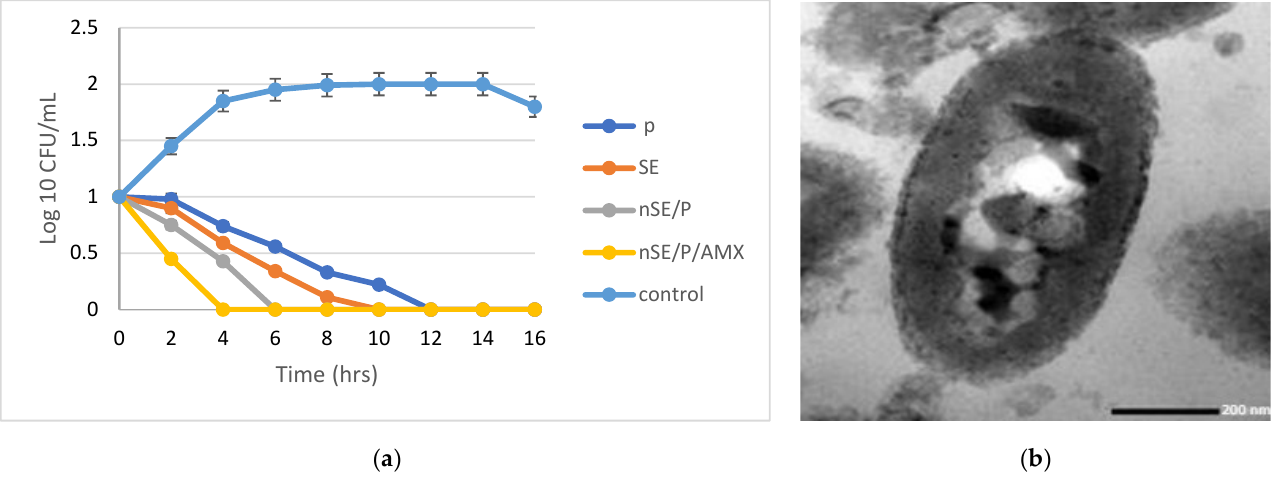
Figure 3. Time kill curve of the bacterial cells treated with SE, P, nSE/P and nSE/P/AMX, one at a time ( a ). Transmission electron micrograph of nSE/P/AMX-treated cells ( b ). Table 6. MIC, MBC and MIC index evaluation of the most promising nanoformula against P. aeruginosa . M.O